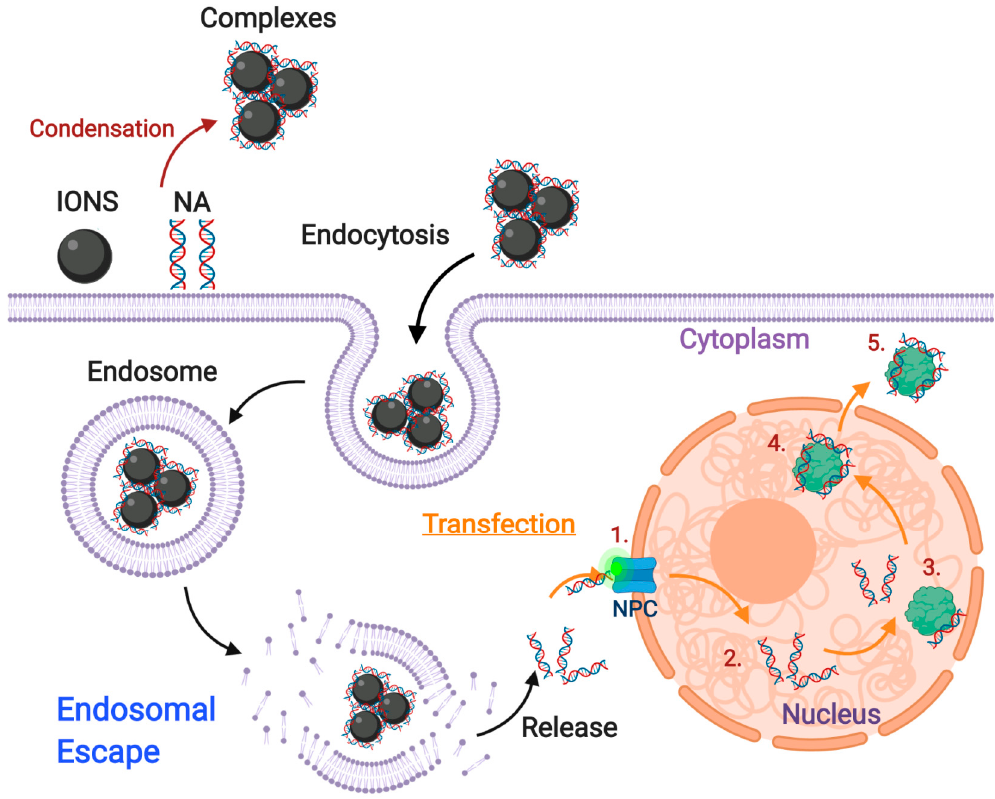
Figure 11. Schematic illustration of the transfection mechanism. After the endosomal escape of the vehicles, the cargo (usually DNA) is released into the cytoplasm. The cargo interacts with the nuclear pore complex (NPC), where importin proteins activate to mediate nuclear internalization ( 1 ). Inside the nucleus, internalized molecules interact with nuclear structures ( 2 ). Subsequently, the remaining molecules bind to RanG proteins ( 3 ) for their recycling ( 4 ) and release into the cytoplasm ( 5 ). (Created with BioRender.com).